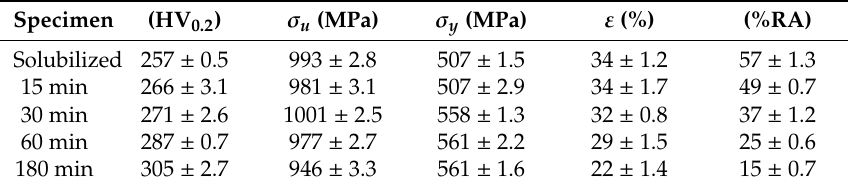
Table 2. Summary of mechanical properties.